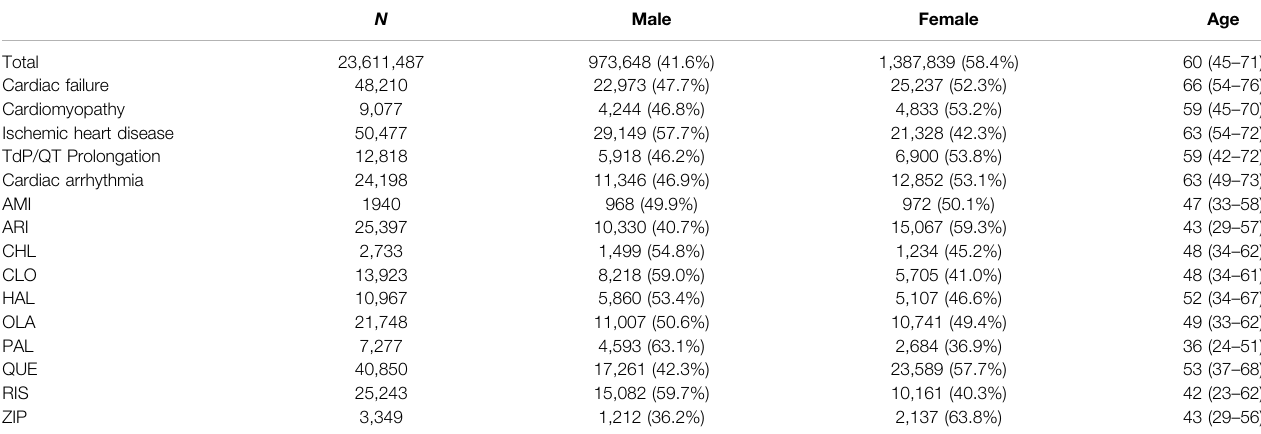
TABLE 1 | Characteristics of cardiac adverse events and antipsychotics in FAERS